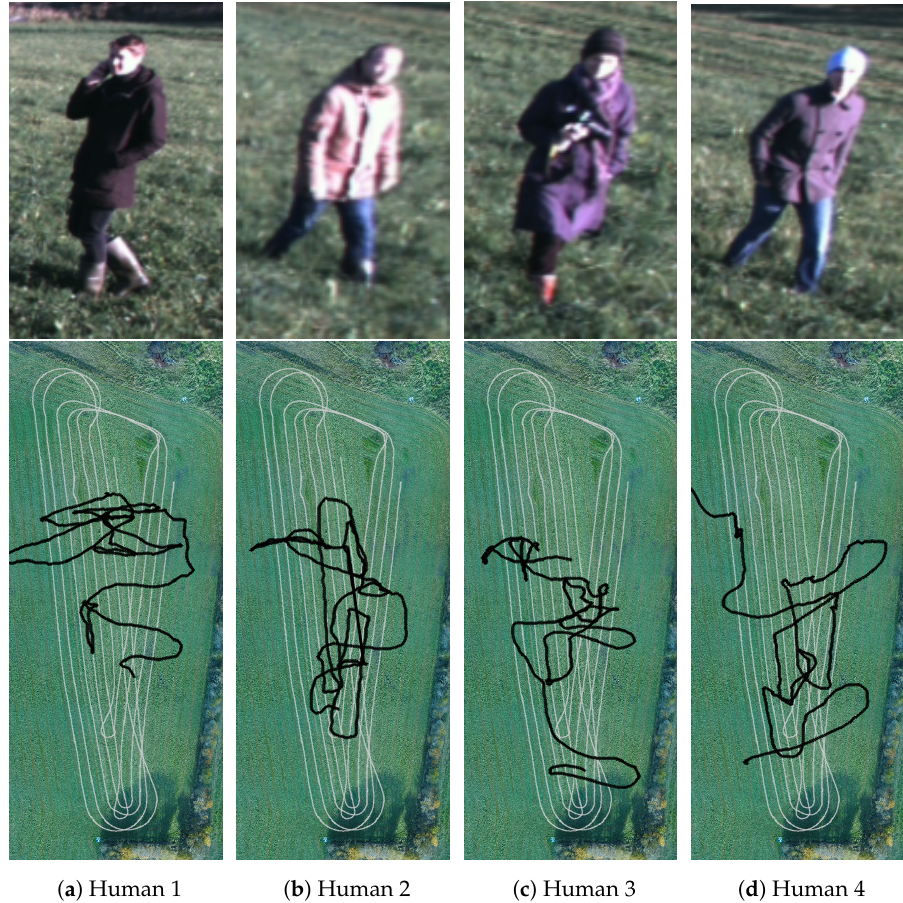
Figure 7. Examples of moving obstacles (from the stereo camera) and their paths (black) overlaid on the tractor path